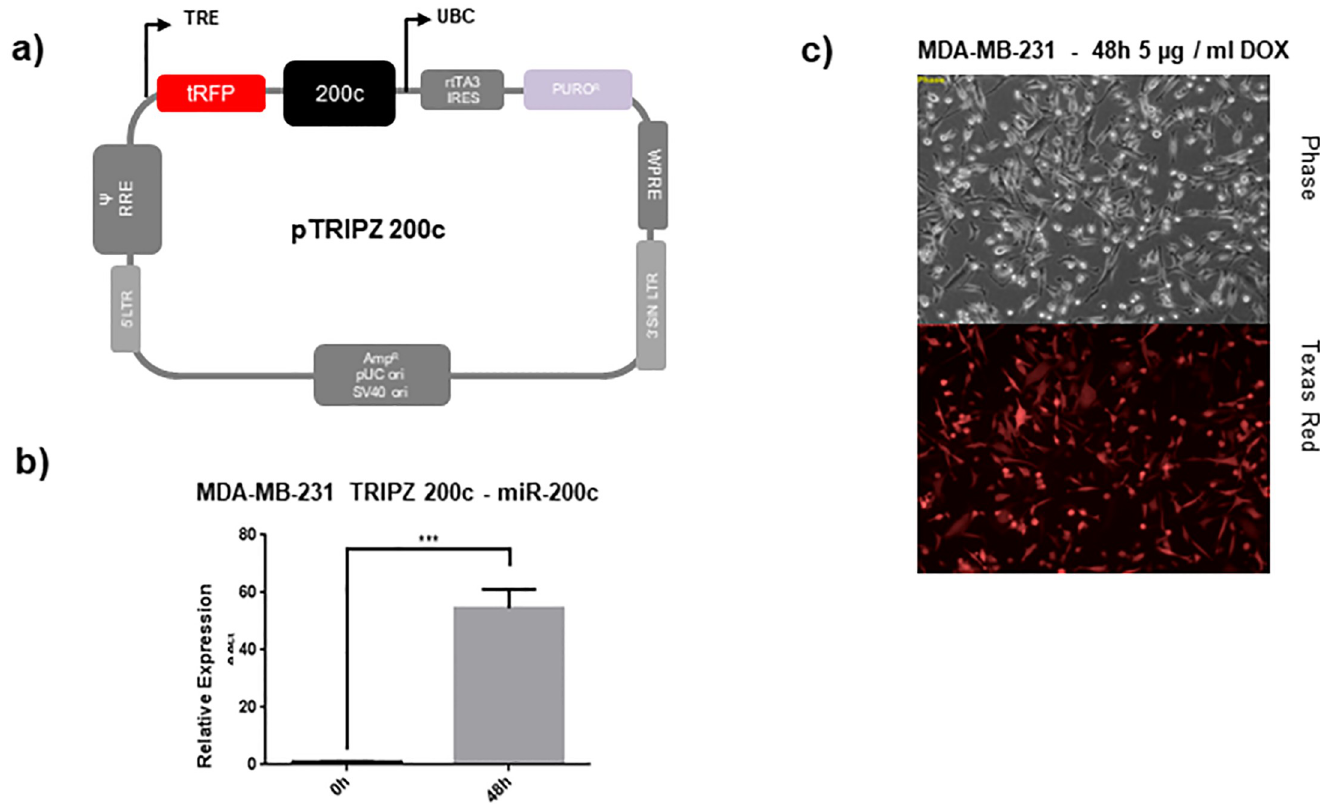
Fig 1. Inducible miR-200c construct with RFP reporter. (a) Description of the inducible pTRIPZ-200c construct (b) and verification of functional transduction in MDA-MB-231 cells by induction of the RFP reporter tag by 5 μ g / ml doxycycline for 48 h. (c) Expression analysis by RT-qPCR of miRNA-200c after induction with 5 μ g / ml doxycycline after 48